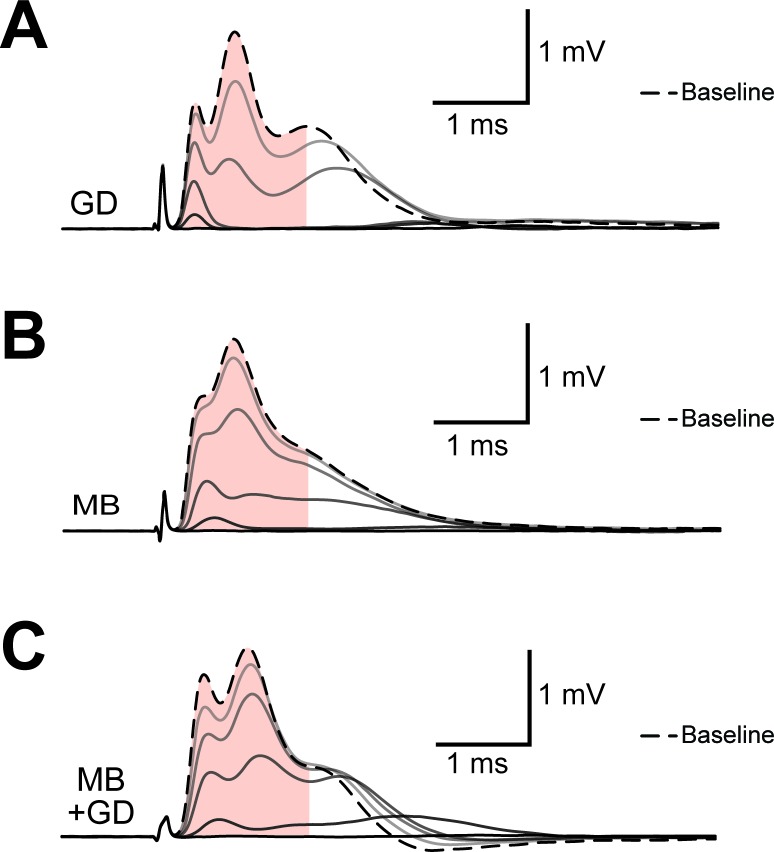
Example of progression of CAP traces’ decay during energy deprivation.Shown are single traces obtained under control conditions (baseline, dashed line) as well as during application of GD (A, total 45 min), MB (B, total 5 min) or MB+GD (C, total 5 min). Single traces are separated by 330 s (A) or 30 s (B,C). The shaded area indicates the area under the CAP wave form used for CAP quantification for the baseline condition, the same time window was used for analysis of CAPs at later time points. Under all conditions, no CAP is elicited by electrical stimulation anymore at the end of the treatment.